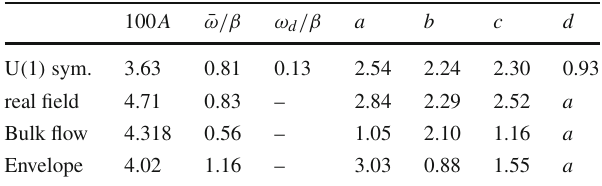
Table 1 Fitted values of the parametrization